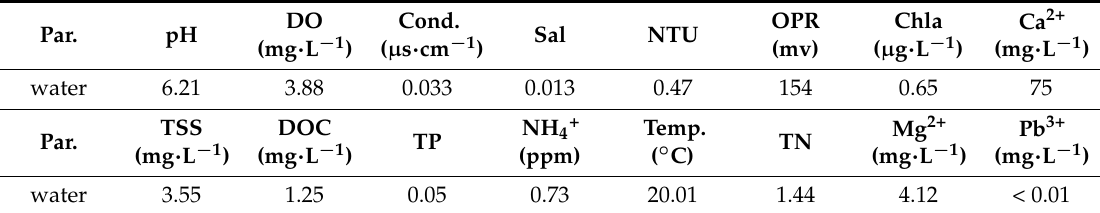
Table A2. Hydrographical and chemical characteristics of stream waters during leaf immersion.